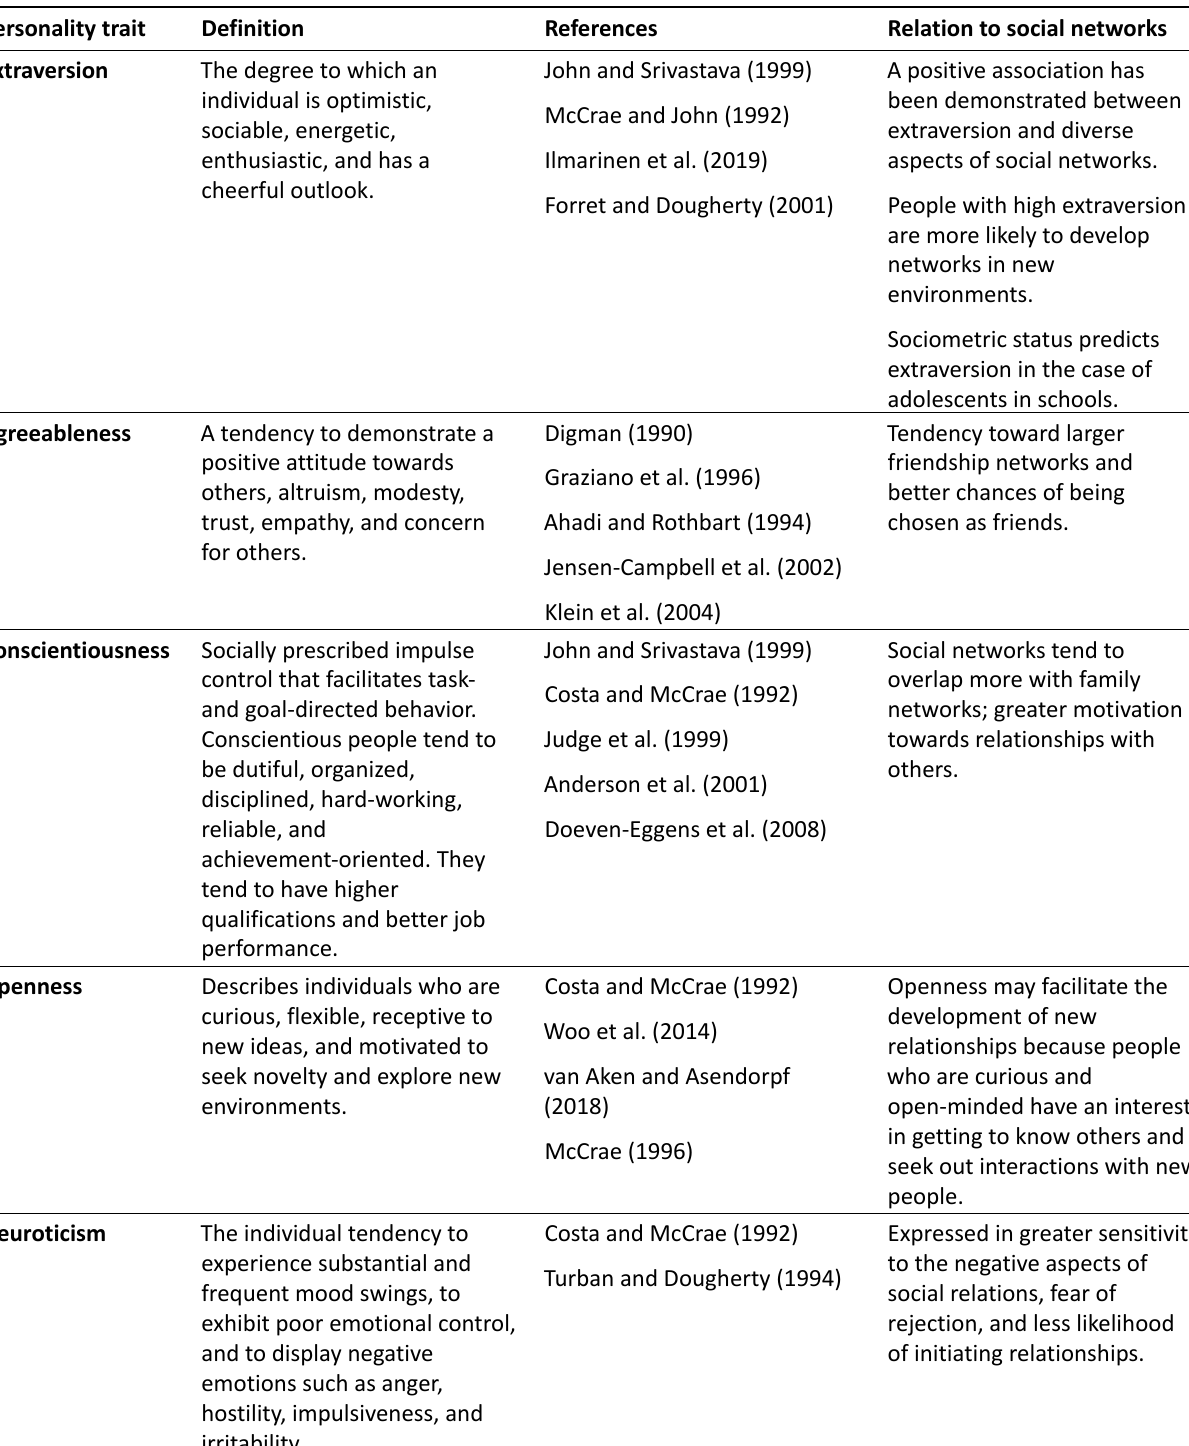
Table 1. The “Big Five Personality Traits” in relation to social